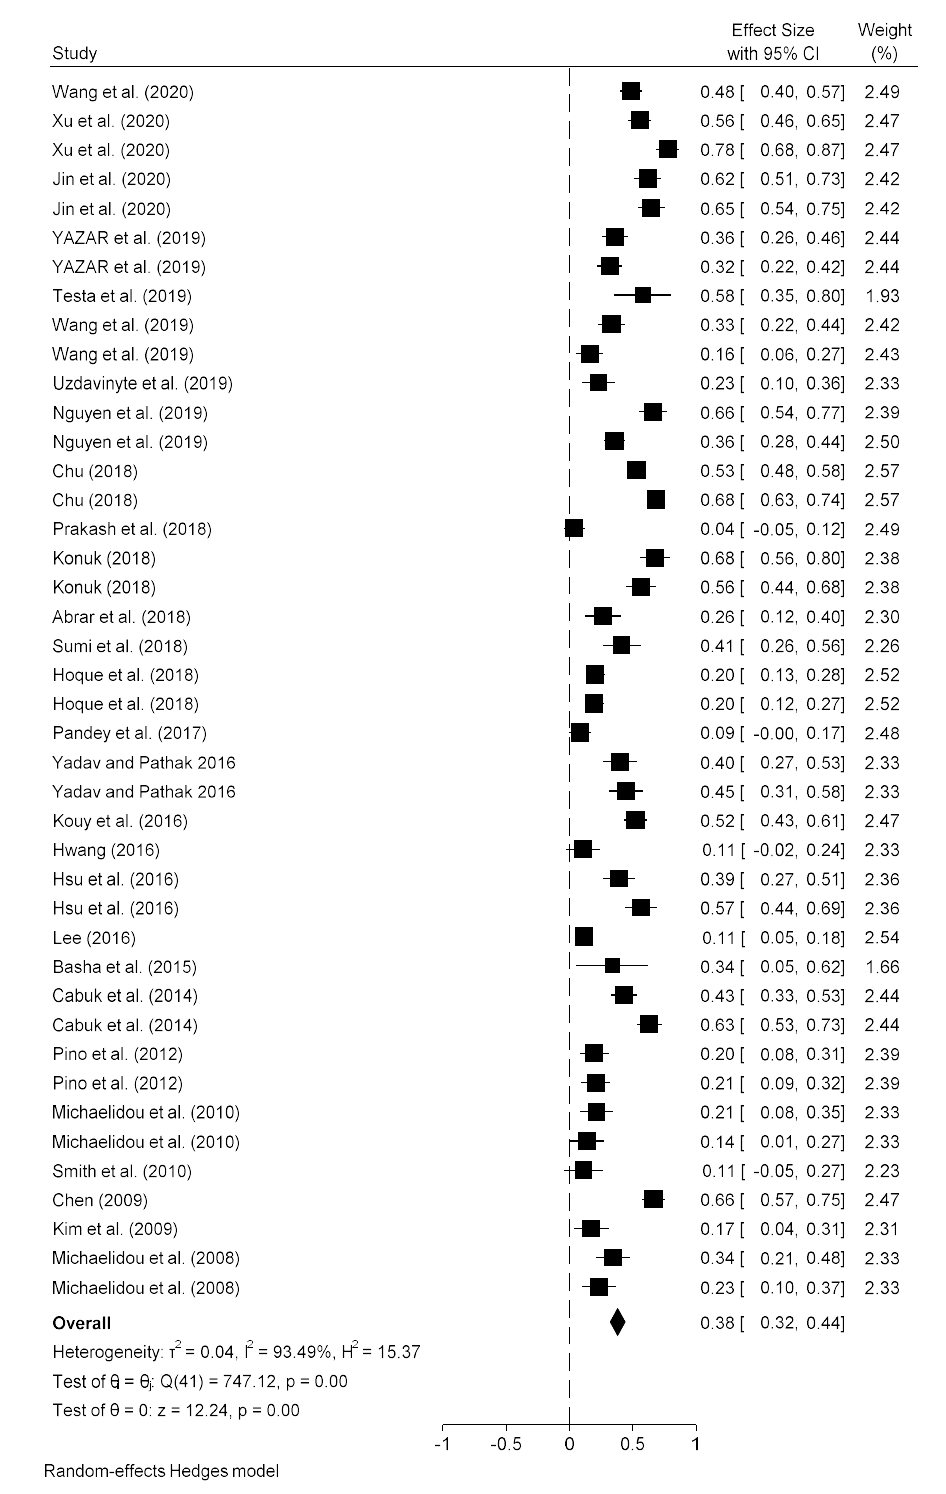
Figure 3. Meta-analysis of the association between health concern and consumer purchase behavior.